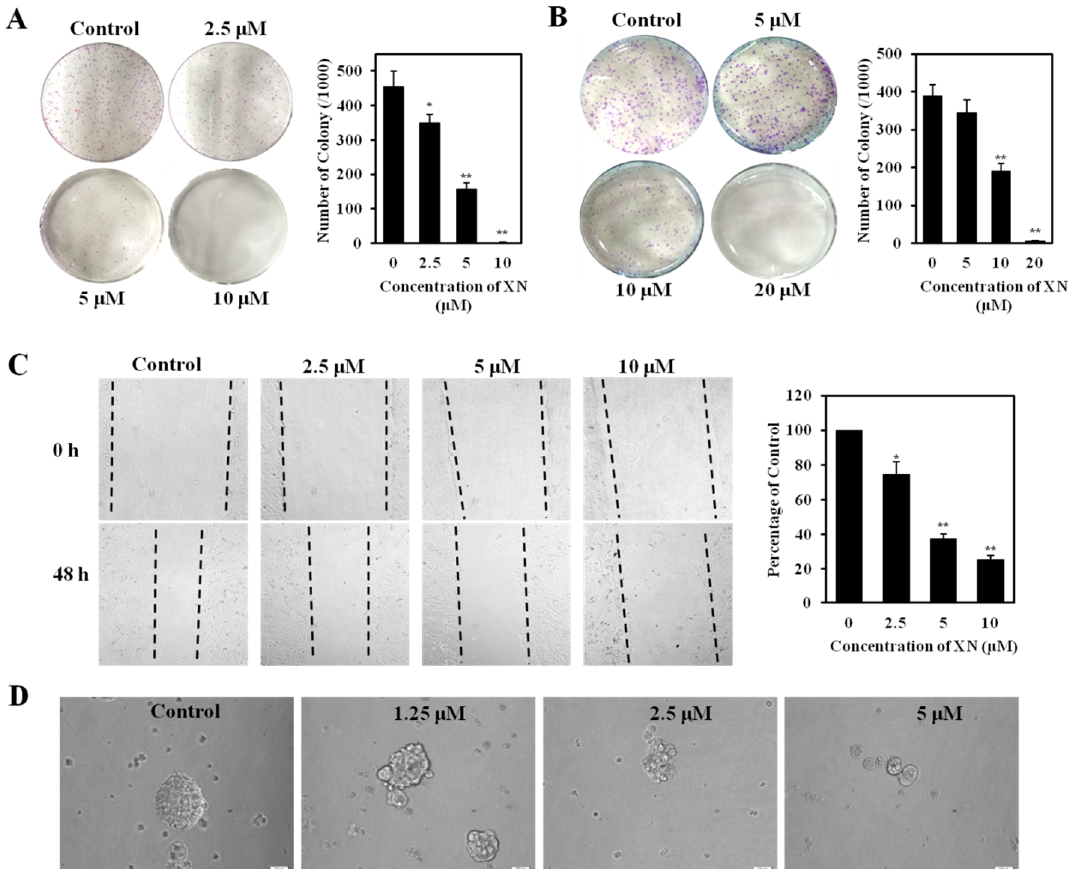
Figure 5. XN decreases the stemness of MCF-7/ADR. ( A ) XN inhibits the colony formation of MCF-7/ADR cells. Colony formation assay was performed as described in the Materials and Methods section. Shown is a representative from three experiments with similar results. The histogram shows the number of colonies in the presence and absence of XN. * p < 0.05, ** p < 0.01 versus medium control; ( B ) XN disturbs the preformed colonies of MCF-7/ADR cells. Values represent the means ± SD of triplicate measurements; * p < 0.05, ** p < 0.01 versus medium control; ( C ) XN inhibits the migration of MCF-7/ADR. Cells were treated with XN (0–10 μ M) for 48 h, and analyzed with scratch-wound assay. Dotted lines show the migration edge of the cells. Histogram shows the relative migration distance in the presence and absence of XN. * p < 0.05, ** p < 0.01 versus medium control; ( D ) XN inhibits mammospheres formation in vitro. MCF-7 cells were cultured in ultra-low-attachment plates with serum-free medium and treated with XN for 25 days. Mammospheres were observed and photographed under microscope (×200, scale bar = 500 μ m).